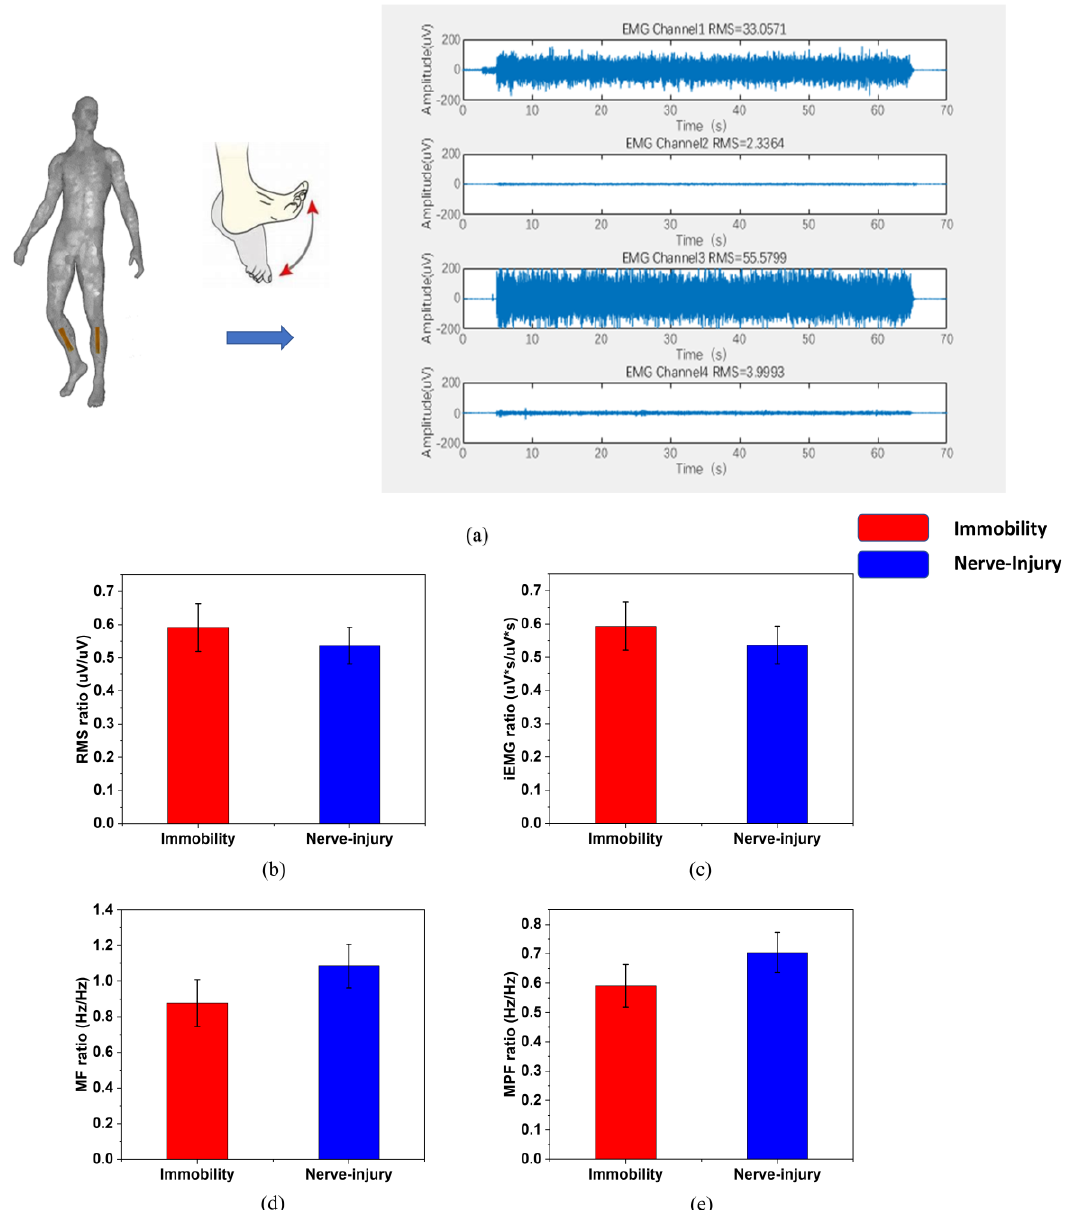
Figure 5. ( a ) The protocol of the moves and the data acquisition on the affected and unaffected sides.